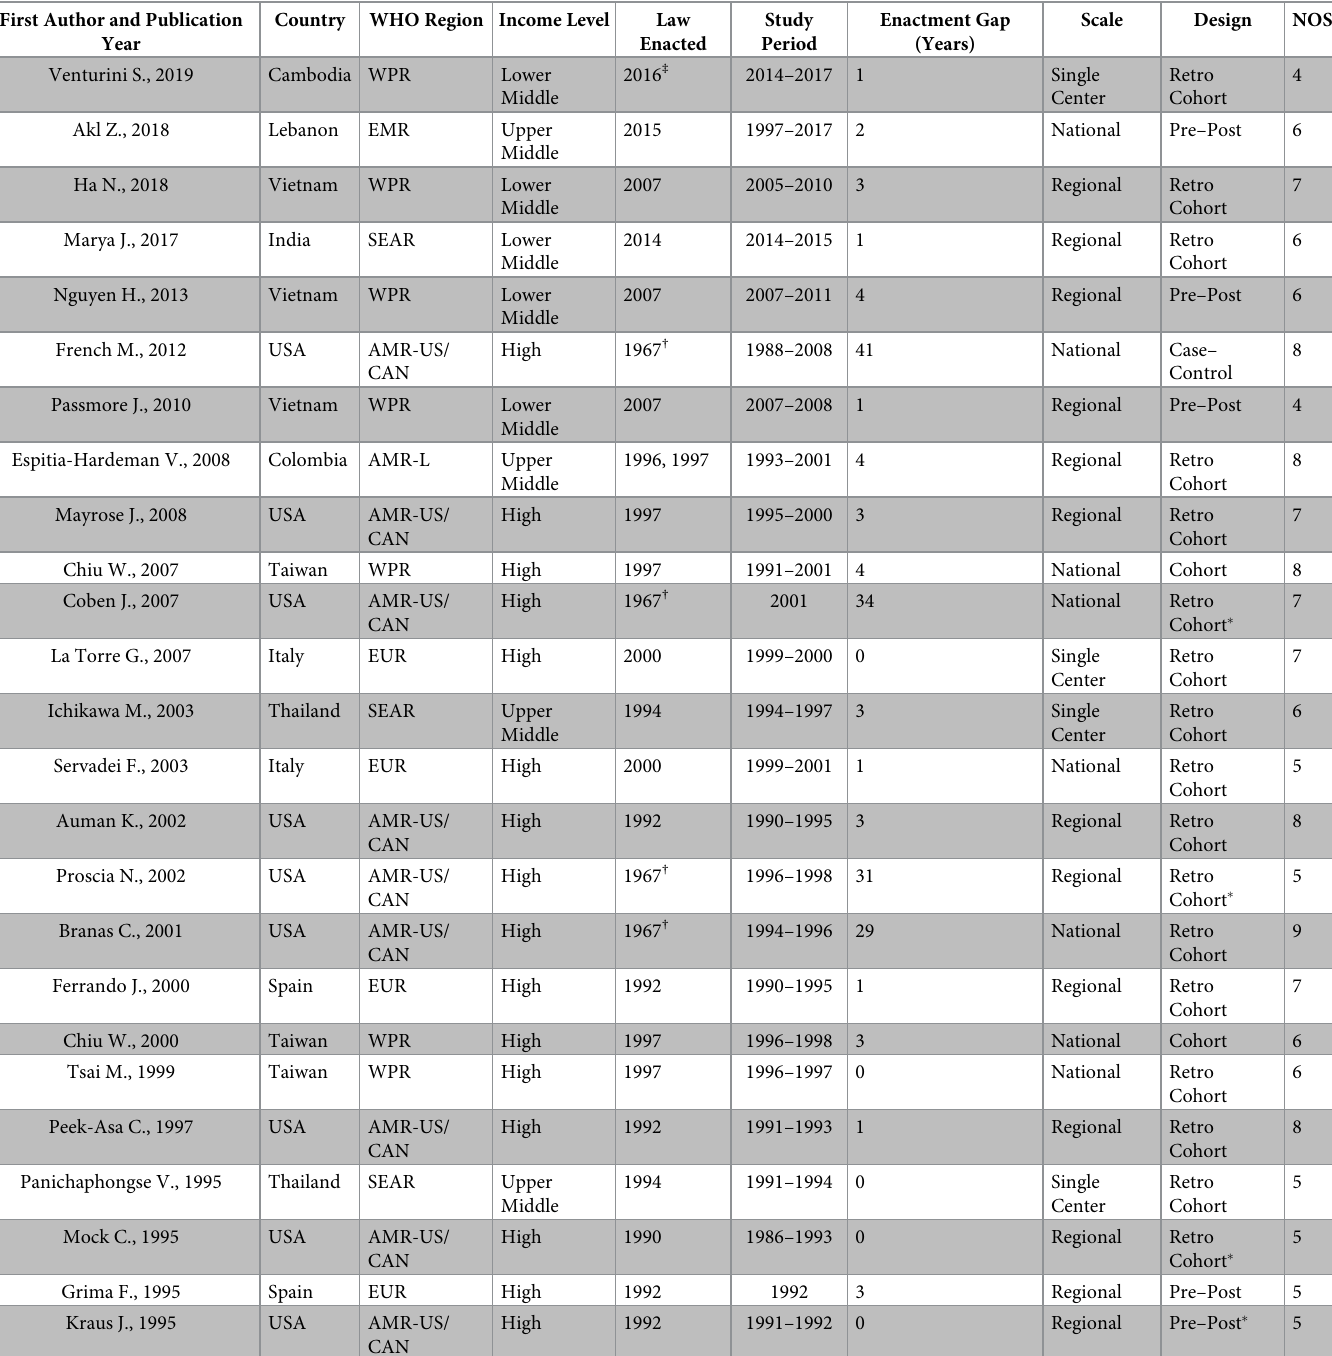
Table 1. Summary of all included studies with study characteristics and reported outcomes with mandatory helmet legislation in